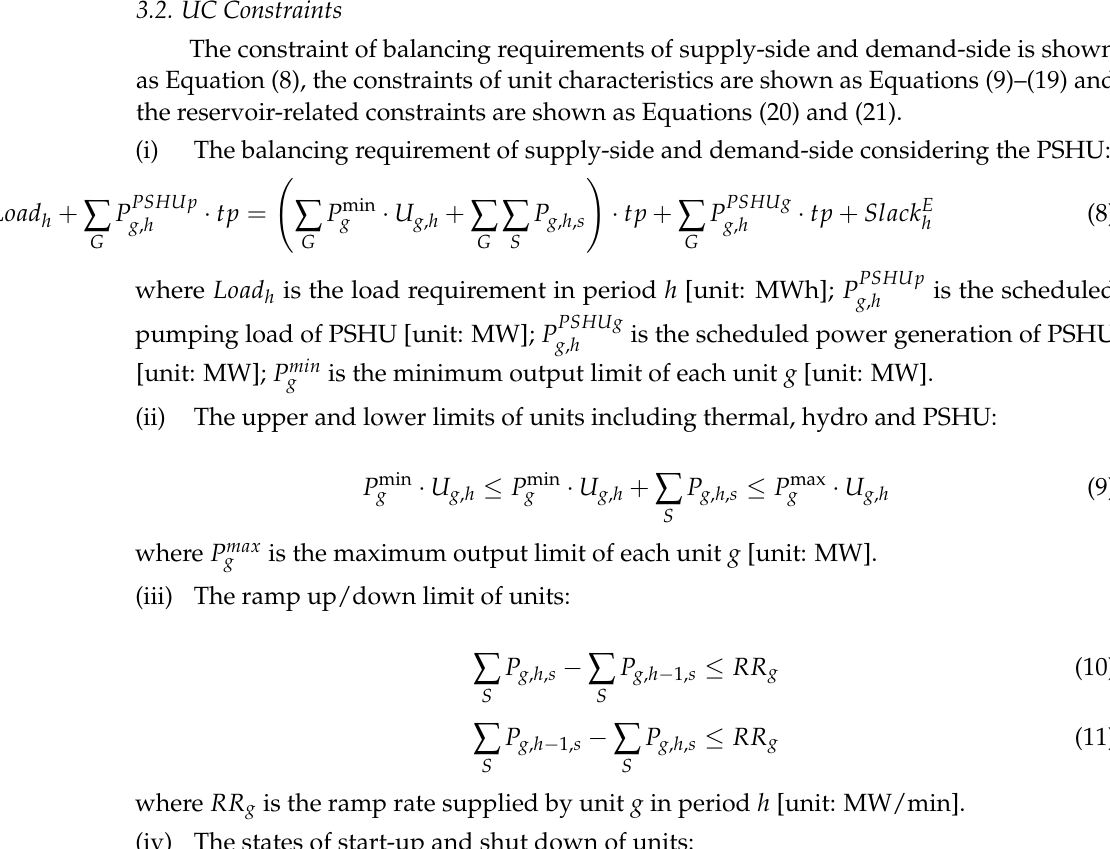
Figure 7. Piecewise fitting function of the incremental fuel cost of each unit.